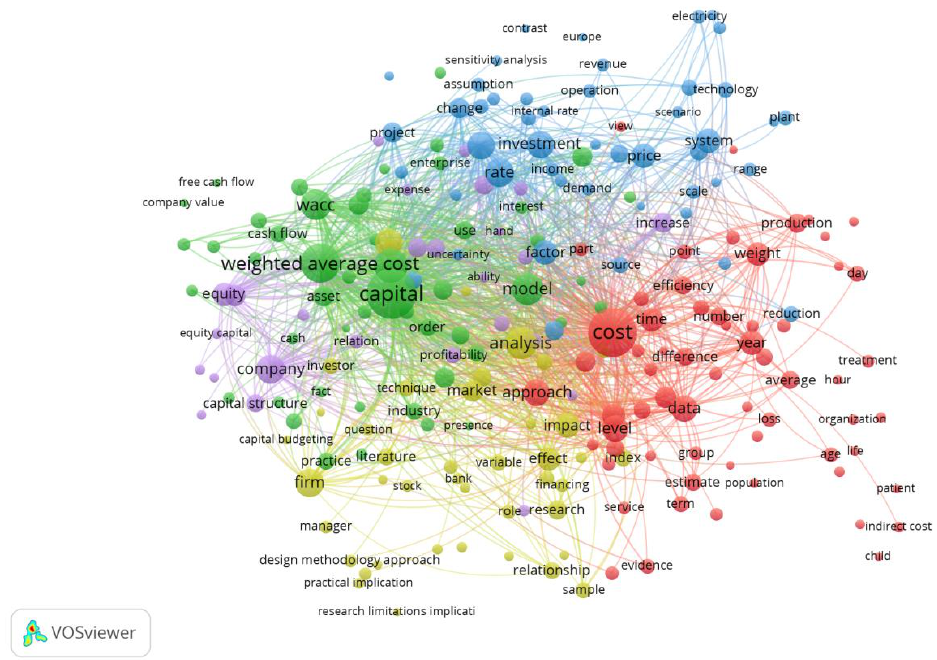
Figure 4. Most common words and the word network in terms of scientific publications’ content